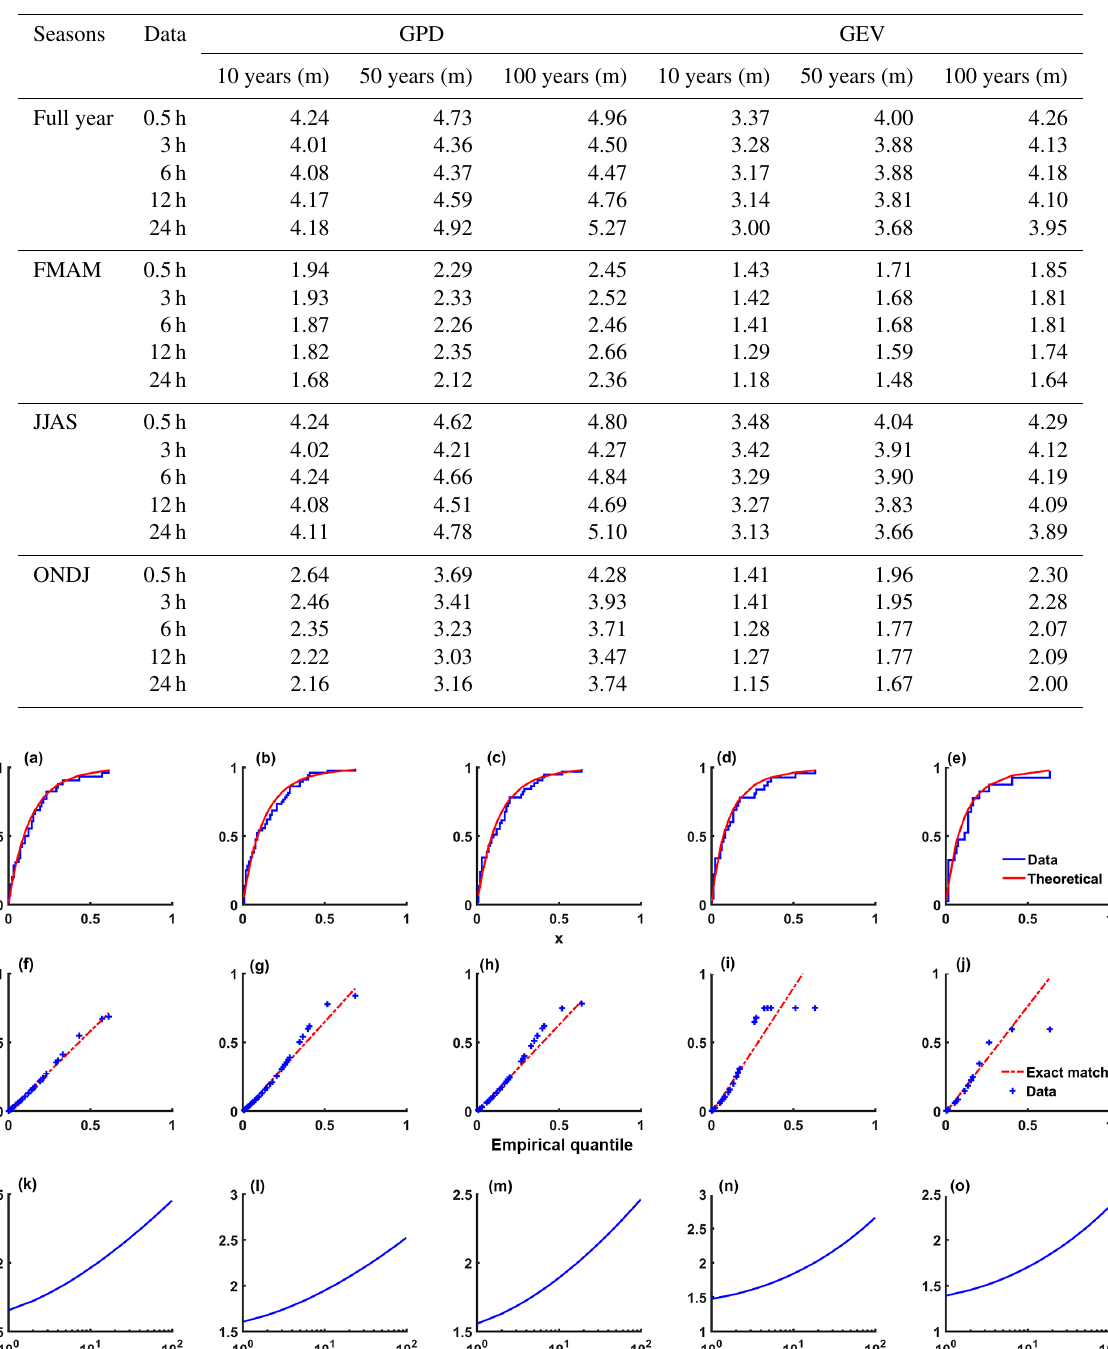
2 m). The seasonal analysis is carried out using H s data fol- lowing both the GEV and GPD methods. Here, the initial distribution method is considered in the GEV method